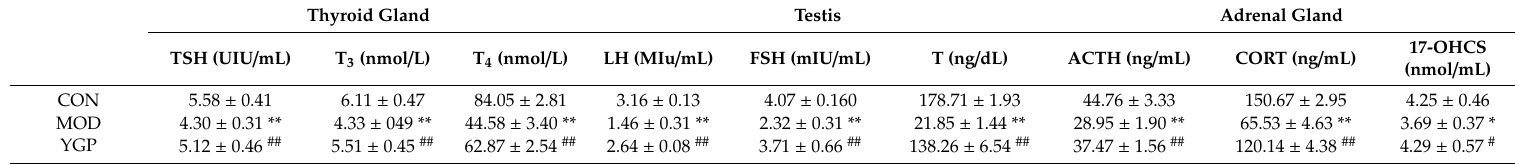
Table 1. Changes in biochemical parameters related to the pathogenesis axis of kidney-yang deficiency syndrome (KYDS)